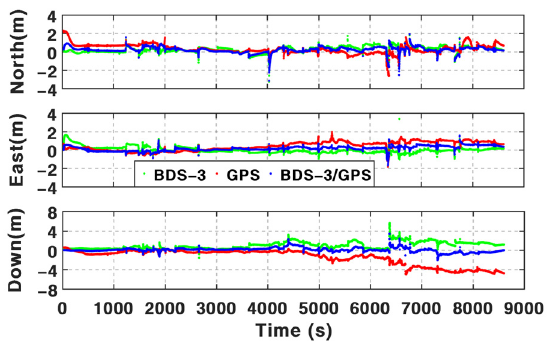
Figure 11. Positioning errors of BSSD PPP/INS/ODO TCI with different GNSS by using PPP-B2b corrections. Table 5. Position RMS of BSSD PPP/INS/ODO TCI with different GNSS.